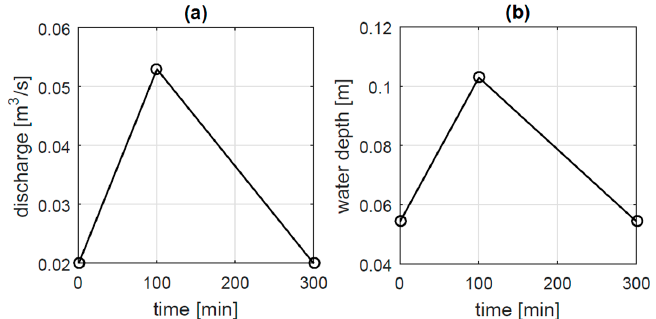
Figure 7. ( a ) Inflow hydrograph and ( b ) outflow water depth of experiment number 4 conducted by Figure 7. Inflow hydrograph and outflow water depth of experiment number 4 conducted by Yen [28]. Yen